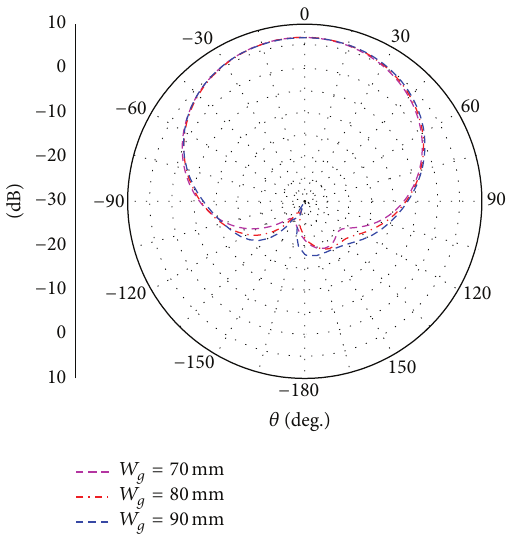
Figure 4: Impact of the ground size on antenna radiation.